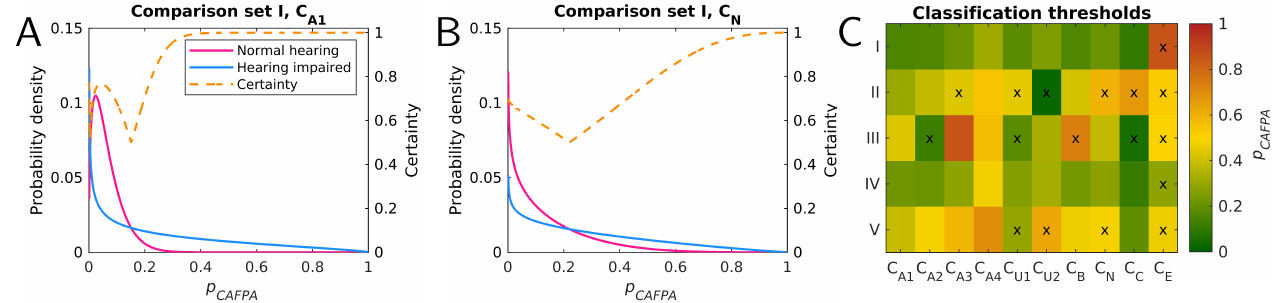
Figure 3. ( A ) Training distributions for C A 1 in CS I (normal hearing (magenta) vs. hearing impaired (blue)), and corresponding certainty value for different input p CAFPA values (orange, dashed). ( B ) As ( A ), for C N . ( C ) Classification threshold p CAFPA values for all five comparison sets (rows). Thresholds correspond to intersections of training distributions, as well as to the minimum of certainty as shown in ( A , B ). Colors represent different p CAFPA values. Values lower than threshold are classified into the first category, and higher values are classified into the second category. Fields marked with “x” provide an expected value of certainty of ≤ 0.65 (averaged over the complete p CAFPA